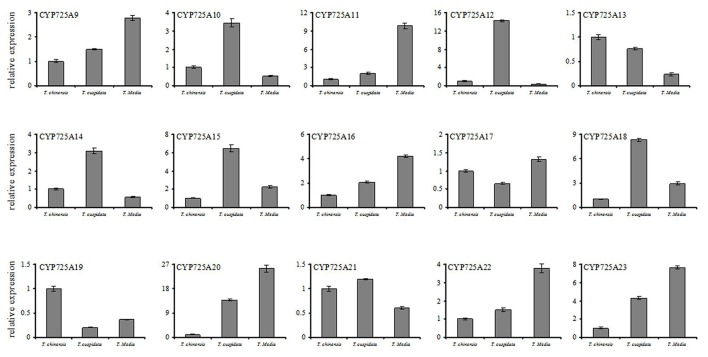
Comparisons of the expression profiles of 15 novel CYP725 genes in different 5-year-old Taxus species, including T. chinensis, T. cuspidate, and T. Media. The bars represent the standard deviation (n = 3).